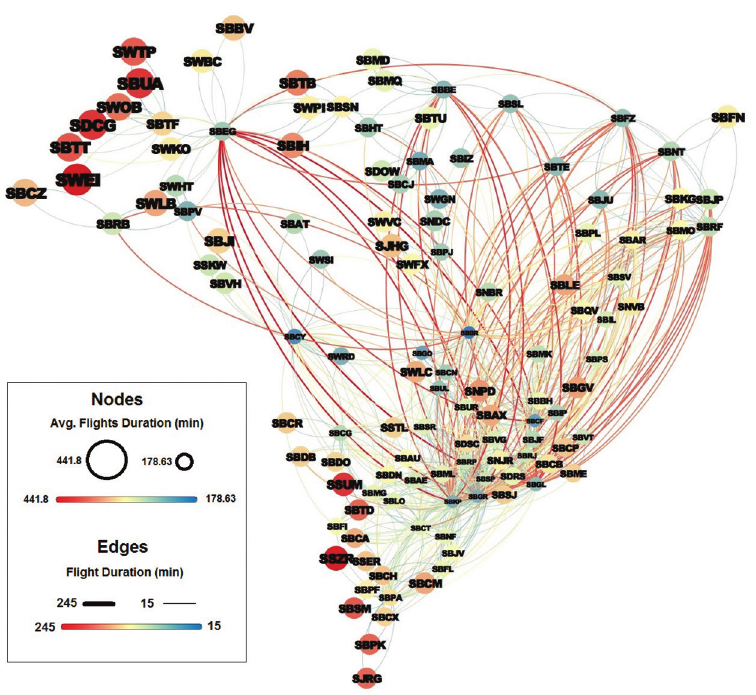
Figure 5 - Brazilian airports and their flights duration representation. For inter- pretation of the references to color in this figure, the reader is referred to the web version of this